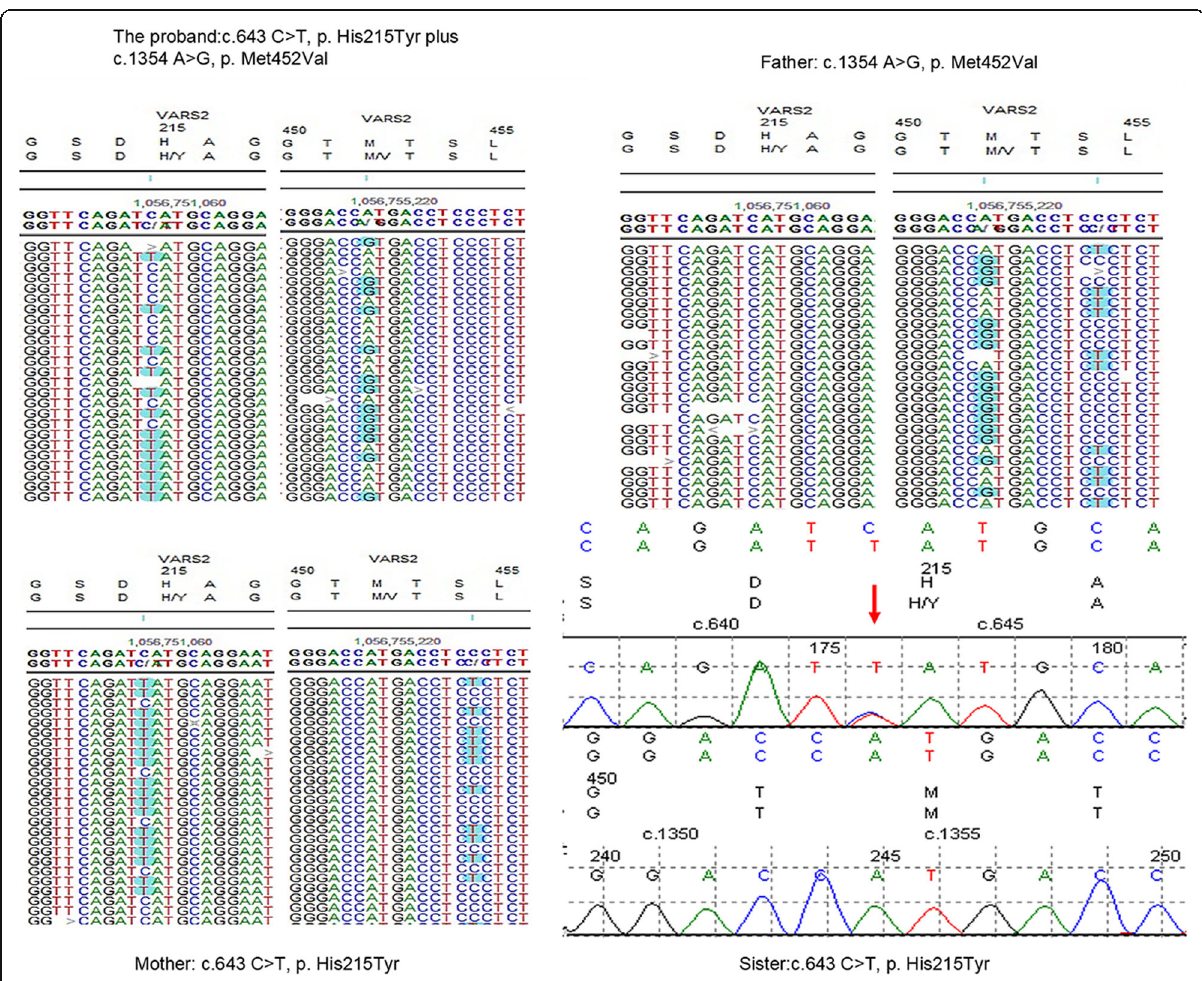
Fig. 2 The DNA sequencing results of the proband and her family (including a number of bases around p.H215 and